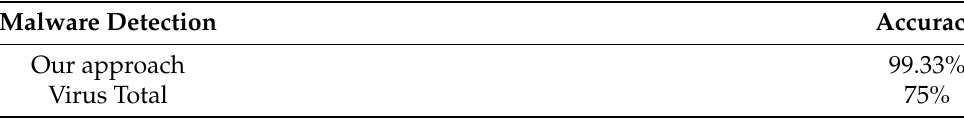
Table 8. Comparison with well known anti-virus